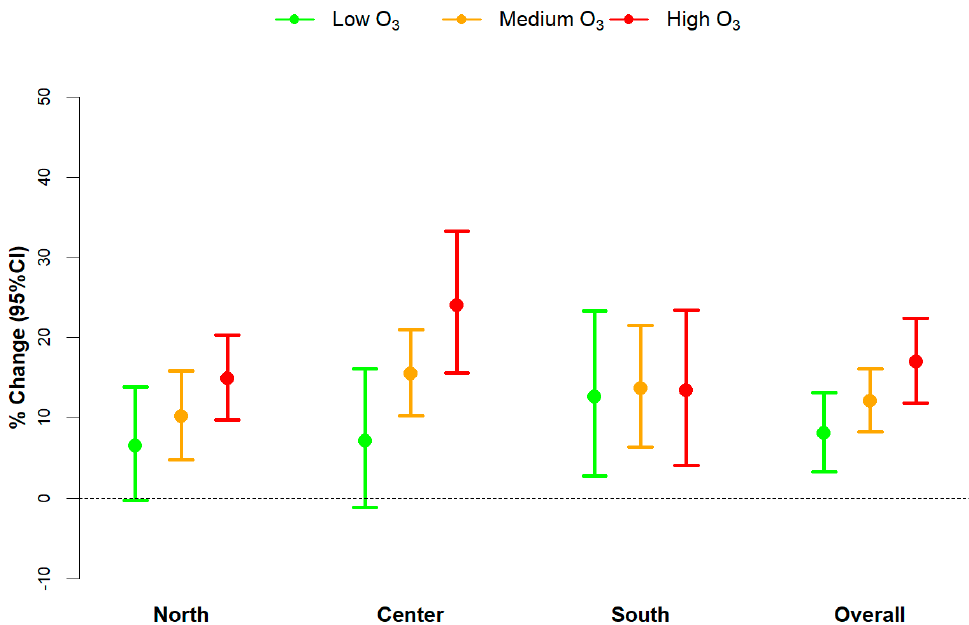
Figure 4. Area-specific (North, Center, South) and overall meta-analytical estimates of the heat effects, stratified by levels of O 3 . Estimates are given as % change in non-accidental mortality, and 95% confidence intervals (95% CI) for mean air temperature increases between the 75th to 99th percentile of city-specific temperature distributions, by levels of O 3 (defined as “low”, “medium”, and “high” based on 5th, 50th, and 95th percentiles of city-specific O 3 distributions).